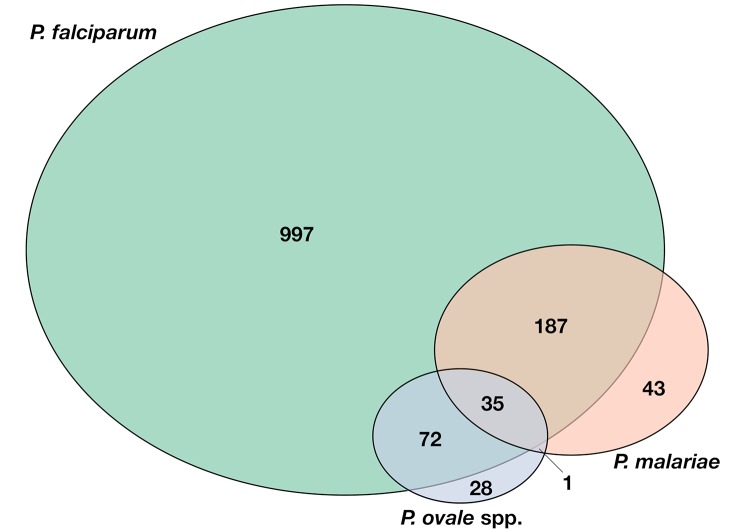
Schematic representation of the number of Plasmodium infections detected throughout the five cross-sectional surveys (total number of tested samples n = 2897).The circles indicate number of samples positive for each Plasmodium species (Green: P. falciparum, Red: P. malariae, Blue: P. ovale spp.). The sections where circles overlap represent the number of co-infection of each combination of more than one Plasmodium species.